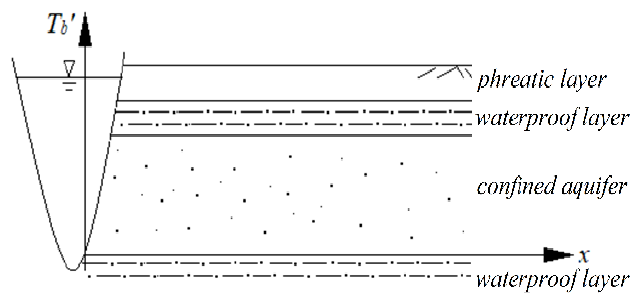
Figure 2. Schematic diagram of river canal and surrounding strata.